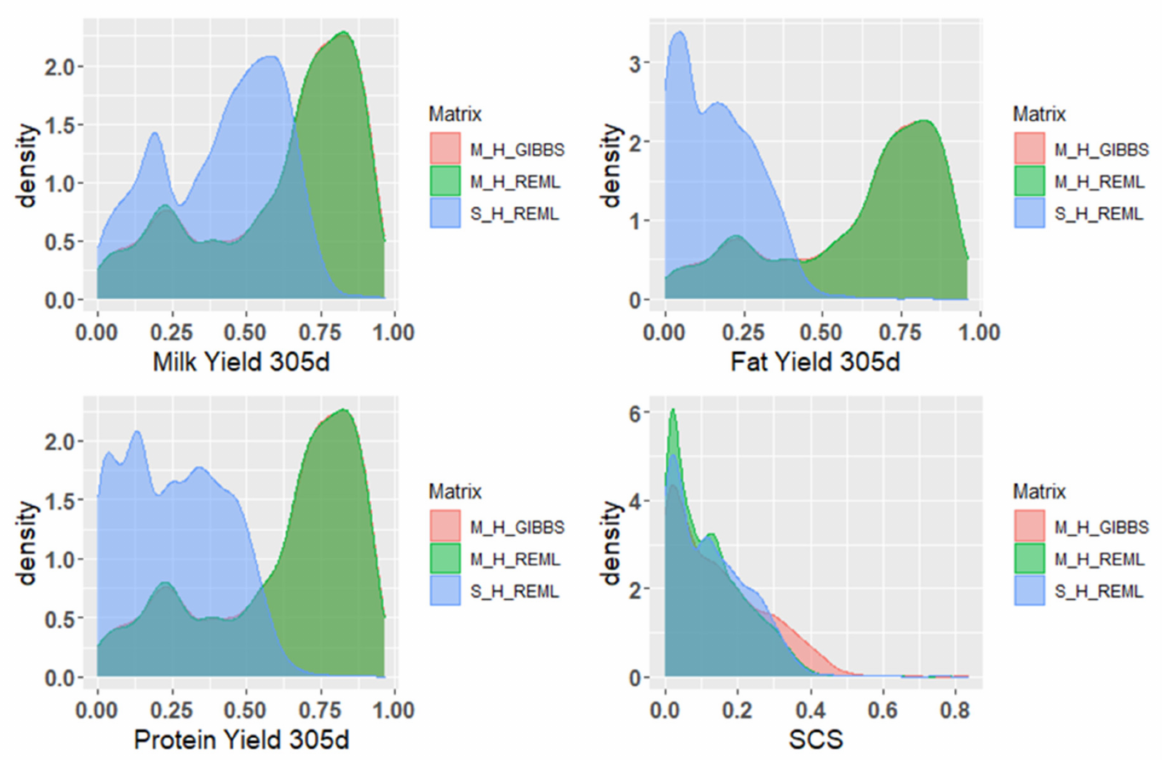
Figure 2. Density map of the reliability of GEBV using different methods of the single-trait and multitrait models. M_GIBBS_H is the reliability of GEBV using the Bayesian method of the multitrait model, M_REML_H is the reliability of GEBV using the REML method of the multitrait model, and S_REML_H is the reliability of GEBV using the REML method of the single-trait